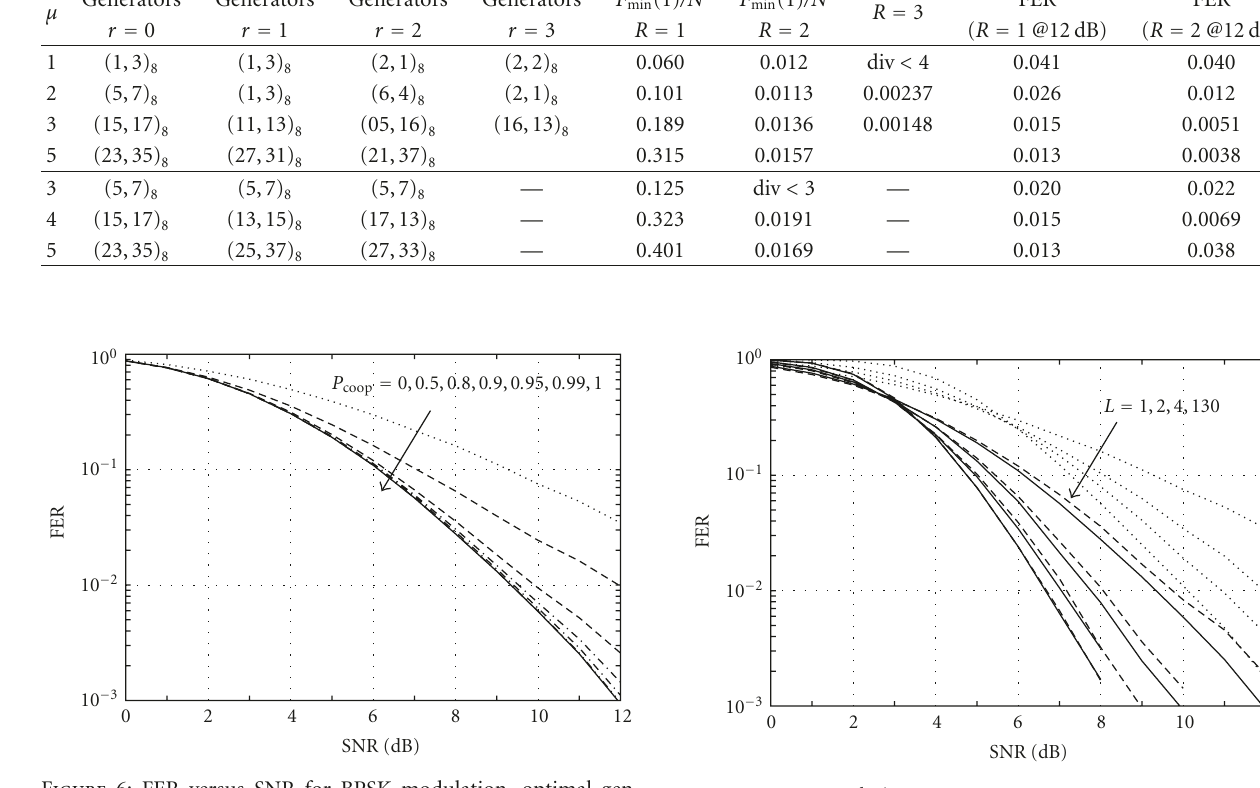
Figure 6: FER versus SNR for BPSK modulation, optimal gen- erators for AWGN, 8 states, two relay, 2 transmitting antennas per node, one receiving antenna, respectively, in quasistatic fading channel ( L = 1).